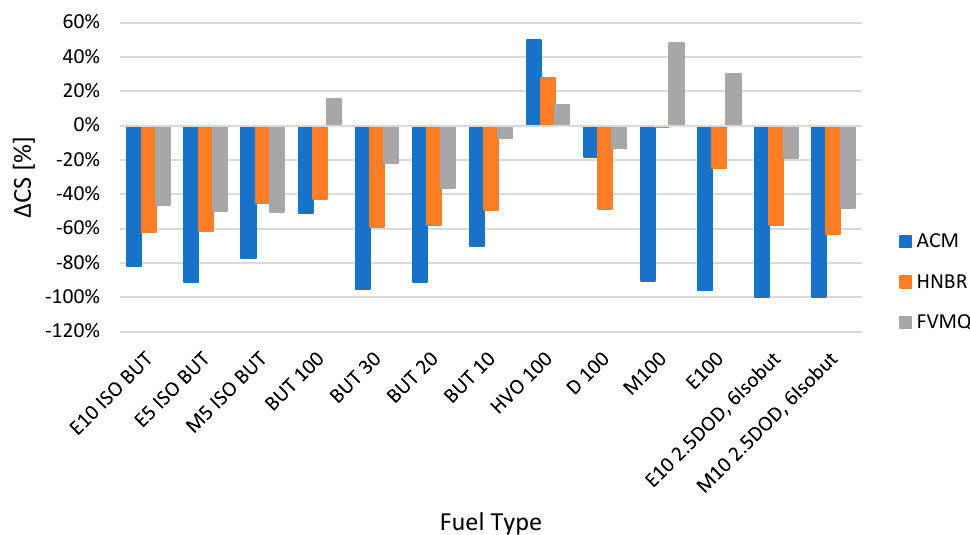
Figure 6. Change in permanent deformation ∆ CS for different elastomer O-rings and fuels after exposure for a time interval of 2998 h.